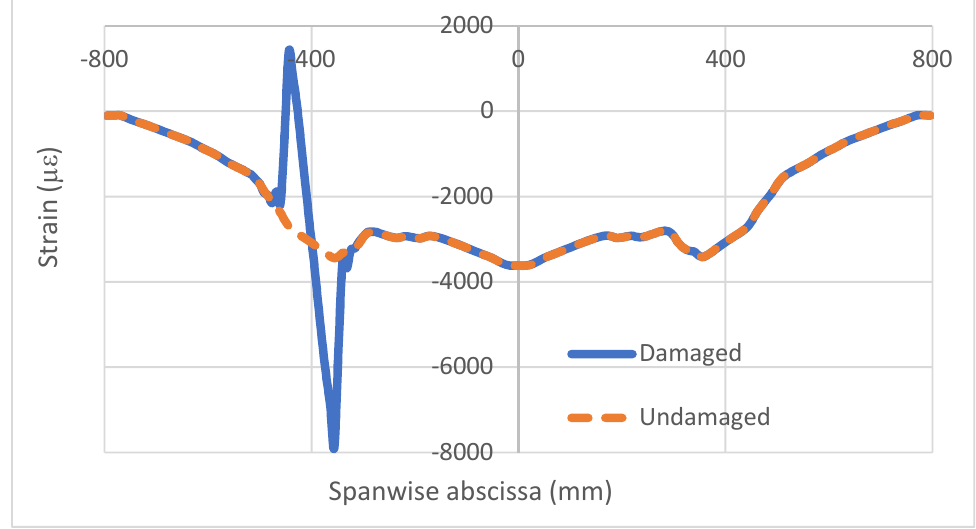
Figure 9. Strain profiles, inner (bottom) and outer (top) cap fiber; symmetrical load.